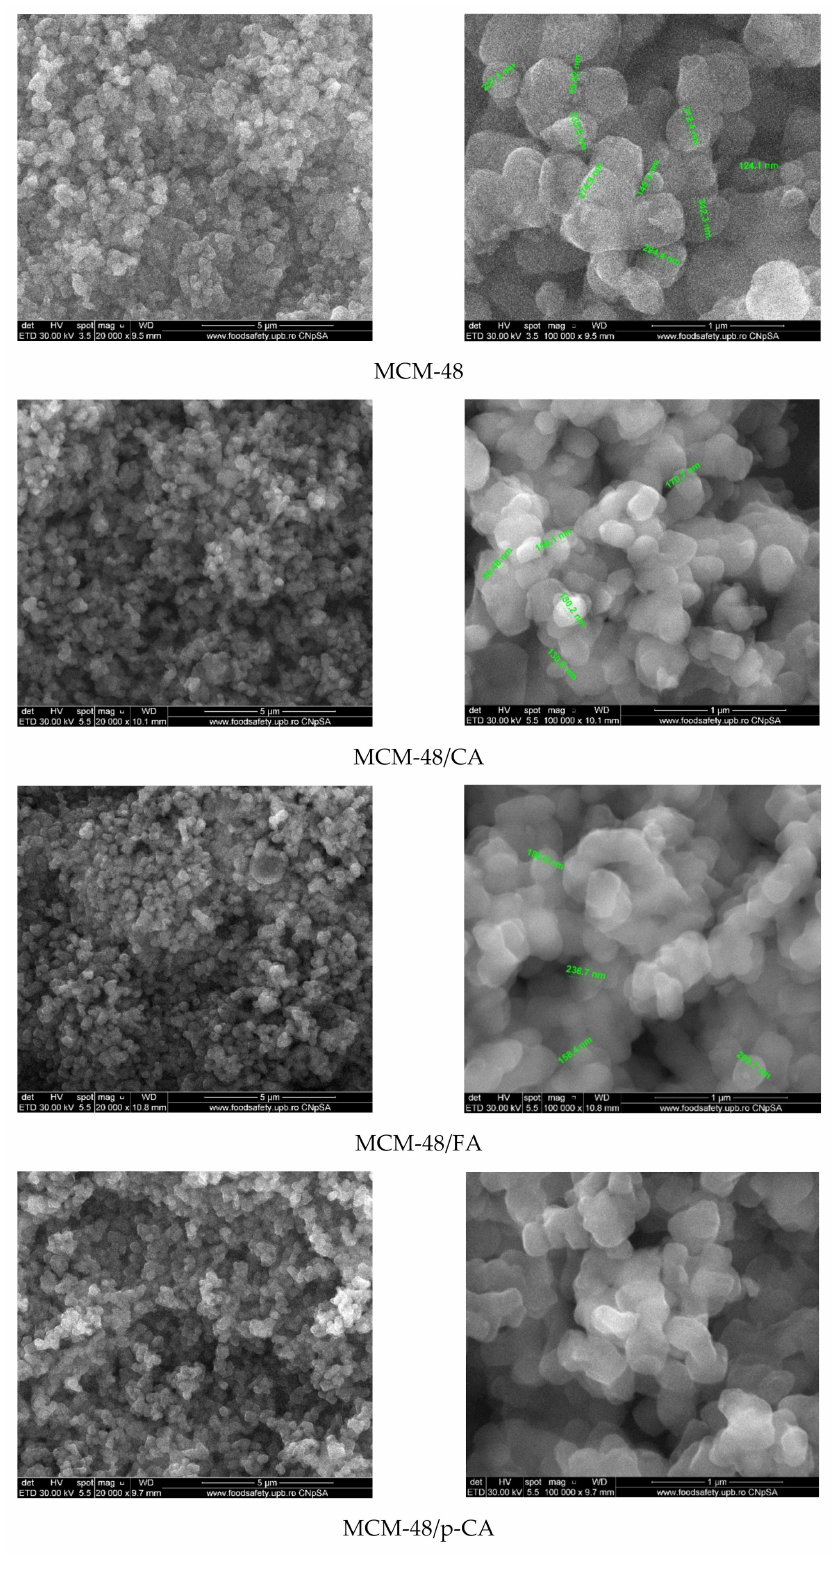
Figure 11. SEM images of MCM-48 mesoporous materials loaded with polyphenols. The thermal stability of the samples, both those consisting of mesoporous mate- rials and those materials loaded with polyphenols, was studied by thermogravimetric analysis (Figure